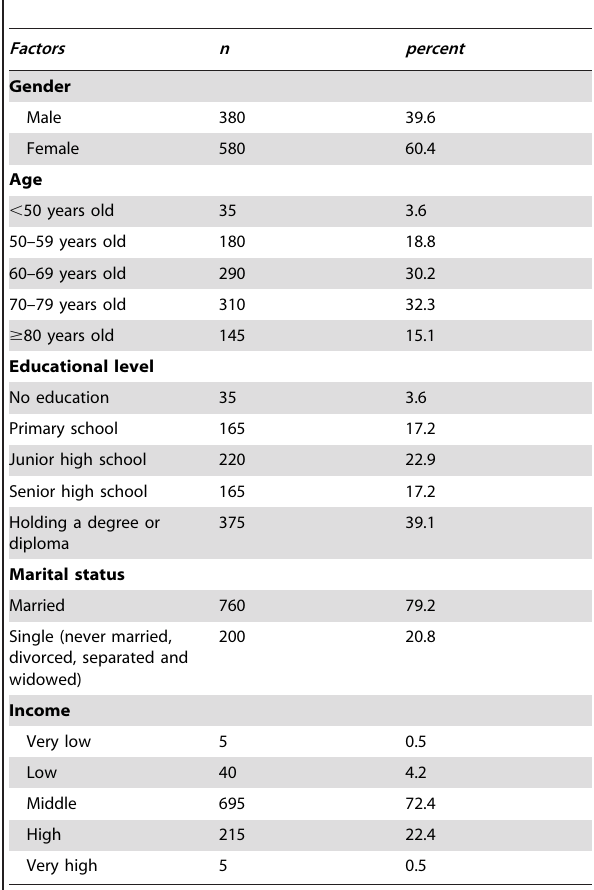
Table 1. The characteristics of the patients with type 2 diabetes (N